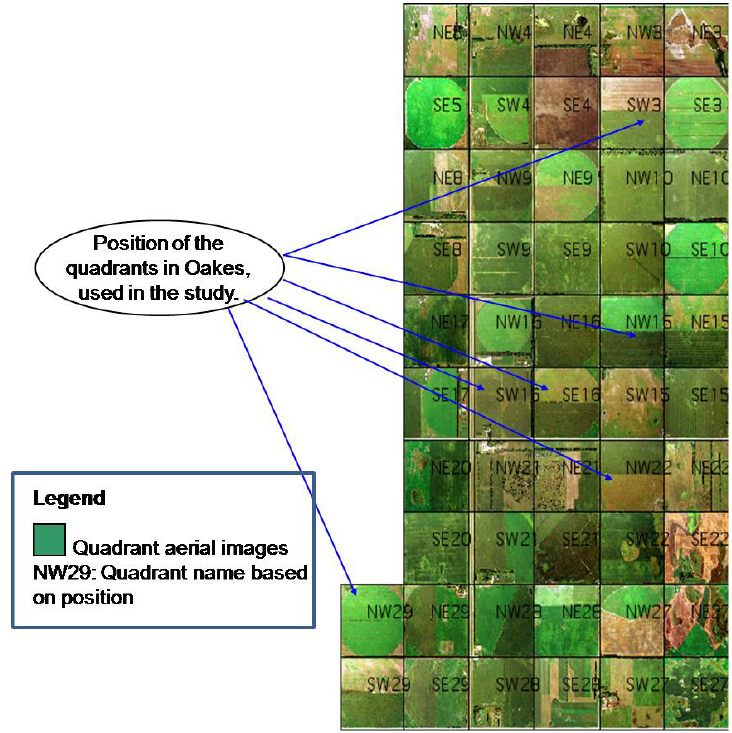
Figure 1. The false color composite (FCC) aerial image of the Oakes area in 1998 showing quarter pattern used for this study.